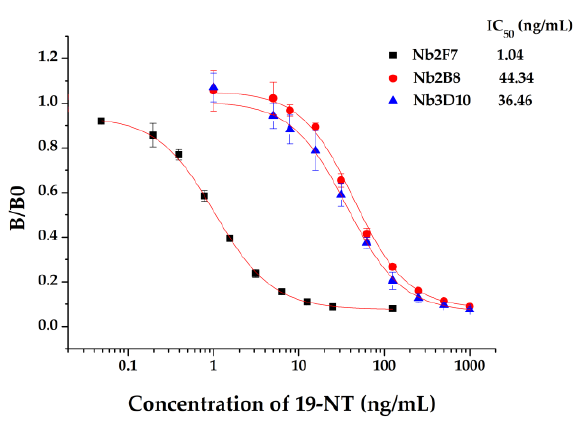
Figure 7. Standard curves of ic-ELISA based on Nb2F7, Nb2B8 and Nb3D10. Table 1. Cross-reactivity of Nbs with 19-NT structural analogues. Analytes